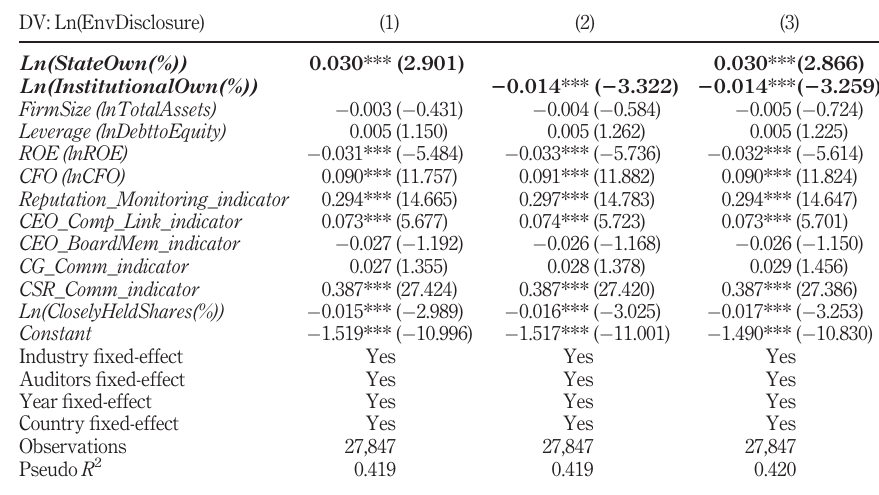
Table 5. Regressions results for H1 and